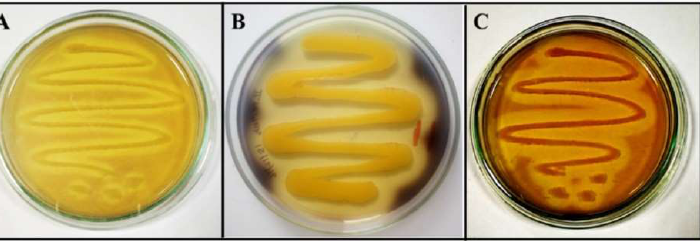
Figure 2. Halo zone observation on ( A ) agar, ( B ) starch and ( C ) xylan plates.